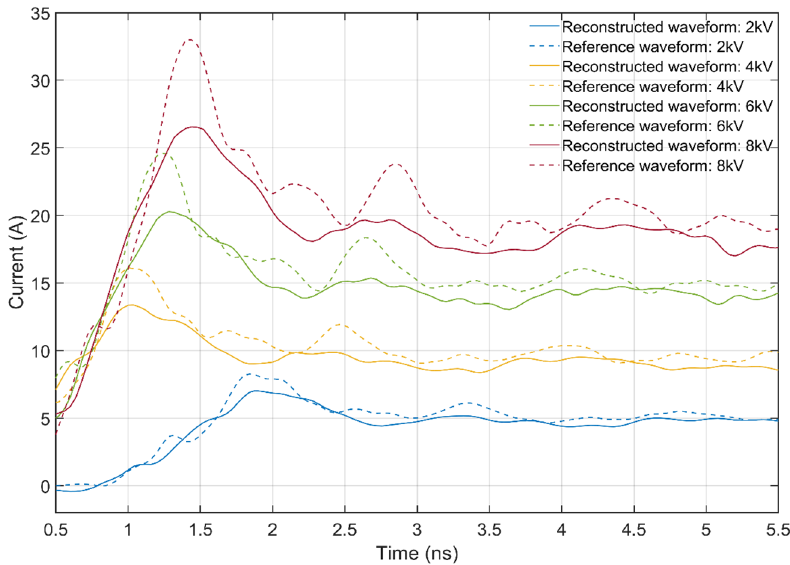
Figure 15. Initial peak comparison of the reconstructed waveform (straight lines) with the Pellegrini target (reference) waveform (dotted lines) for a +2 kV (blue), +4 kV (yellow), +6 kV (green) and +8 kV (red) pulse of the Schaffner NSG 433 generator.